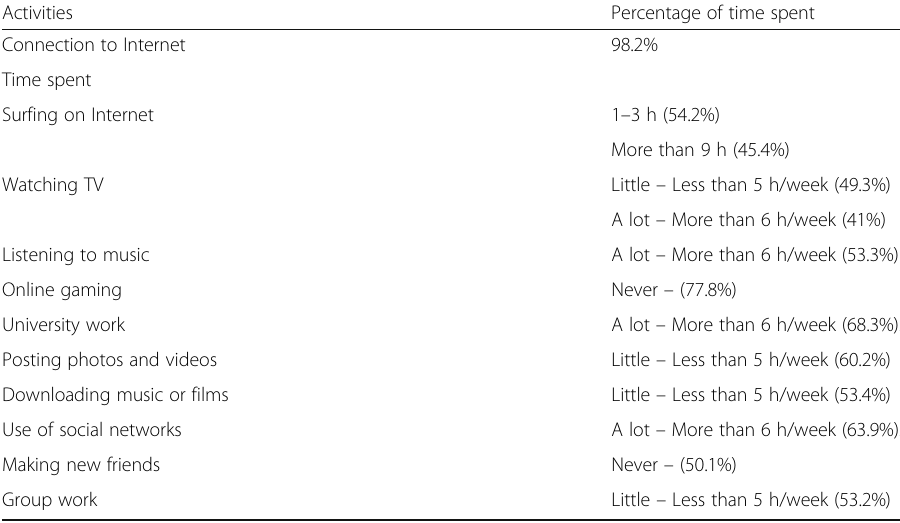
Table 3 Connection, activities and time spent on Internet